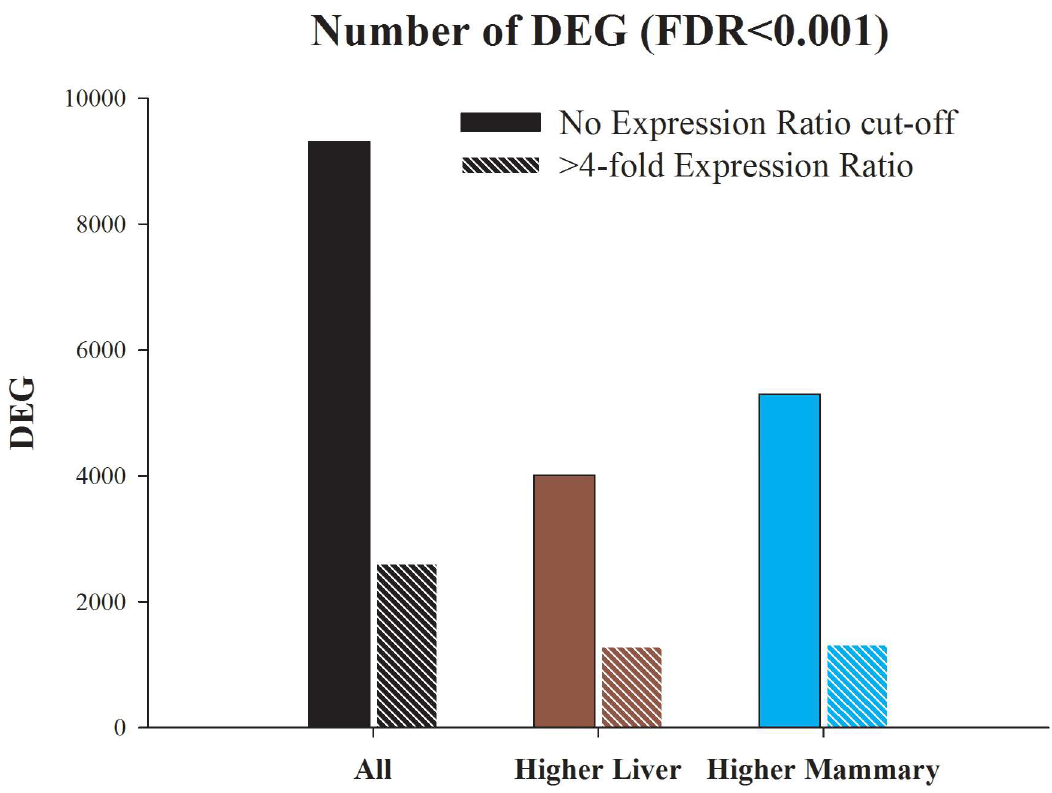
Fig 1. Number of differentially expressed genes (DEG; Benjamini & Hochberg false discoveryrate or FDR (cid:20) 0.001) between liver and mammarytissue obtained from mid-lactation primiparous dairy cows. Shownare all DEG, the DEG more expressed in liver comparedwith mammary tissue, andthe DEG more expressed in mammary tissue compared with liver. Presentedare alsothe DEG with > 4-foldexpression ratio betweenthe two tissues.